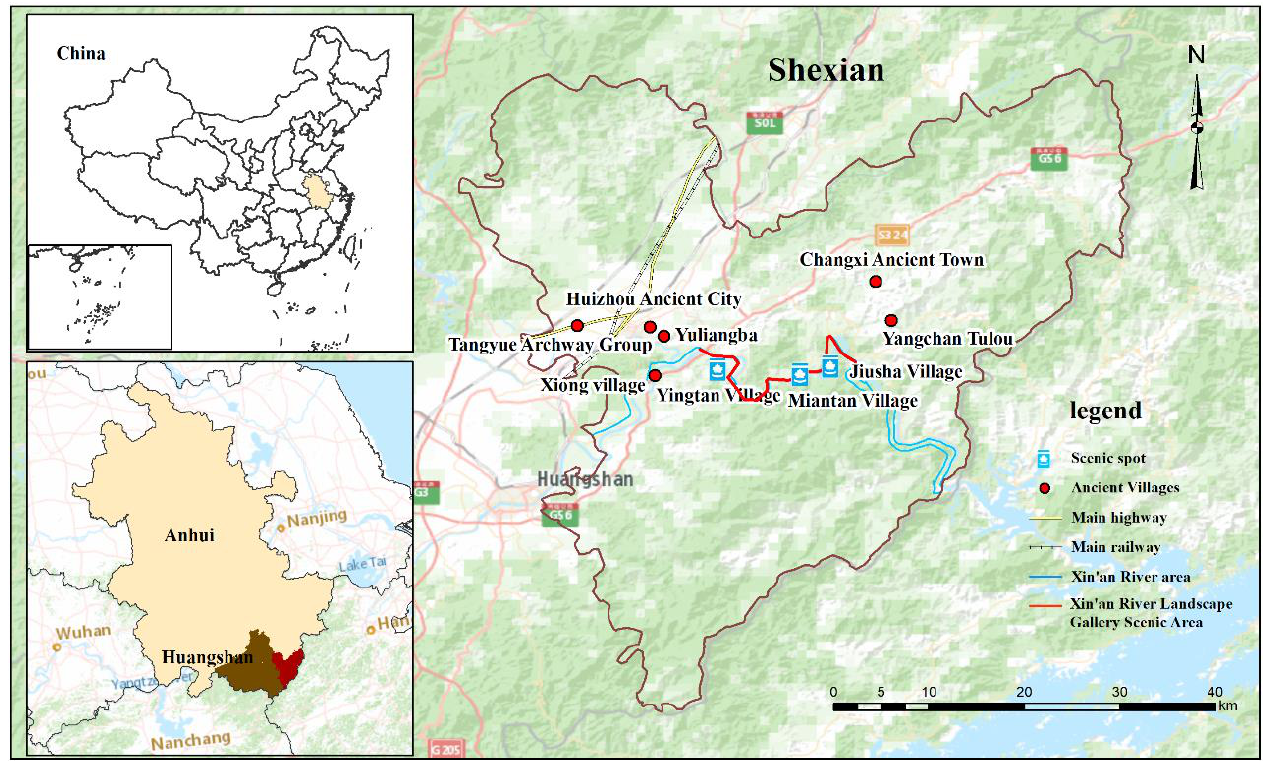
Figure 1. The location of the study area.